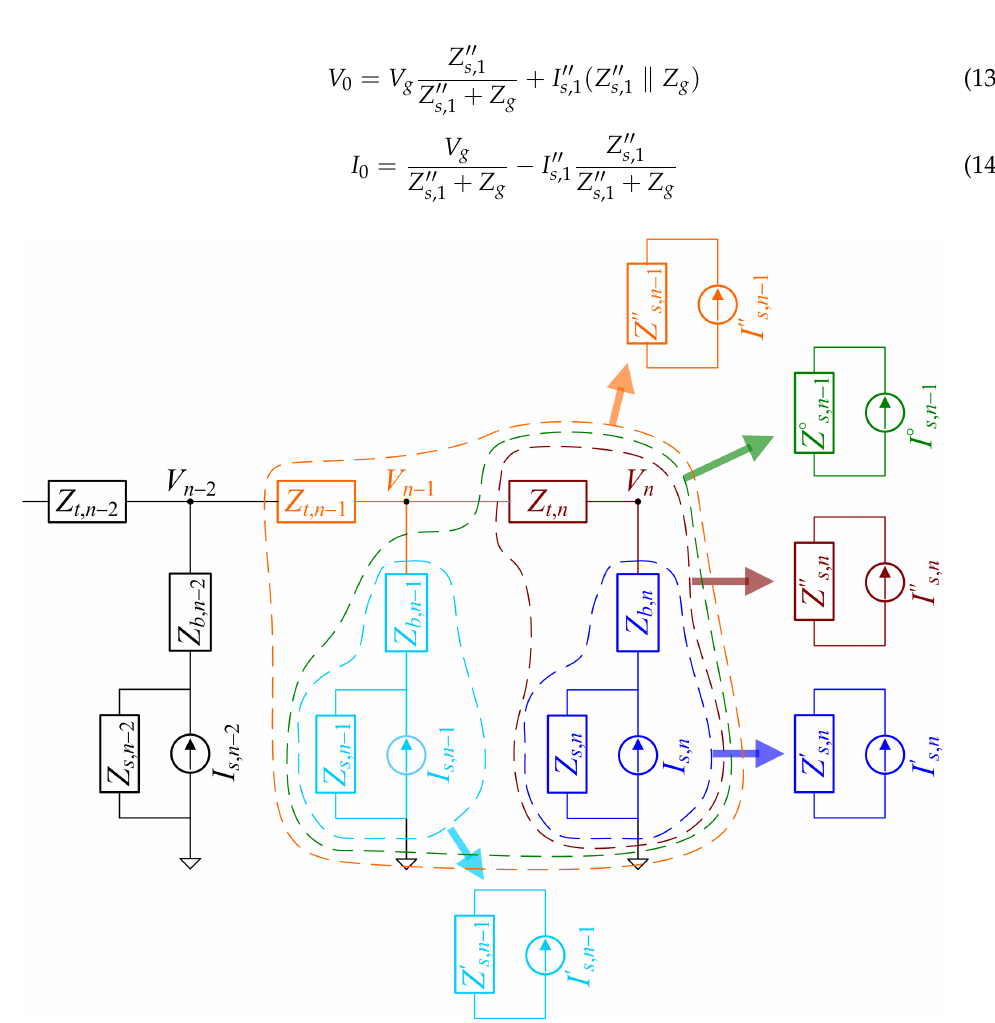
Figure 4. Iterative simplifications of the network electrical circuit: blue and light blue for the source equivalent circuit, green for the parallel combination between two adjacent source blocks; brown and orange for inclusion of the line segment impedance.